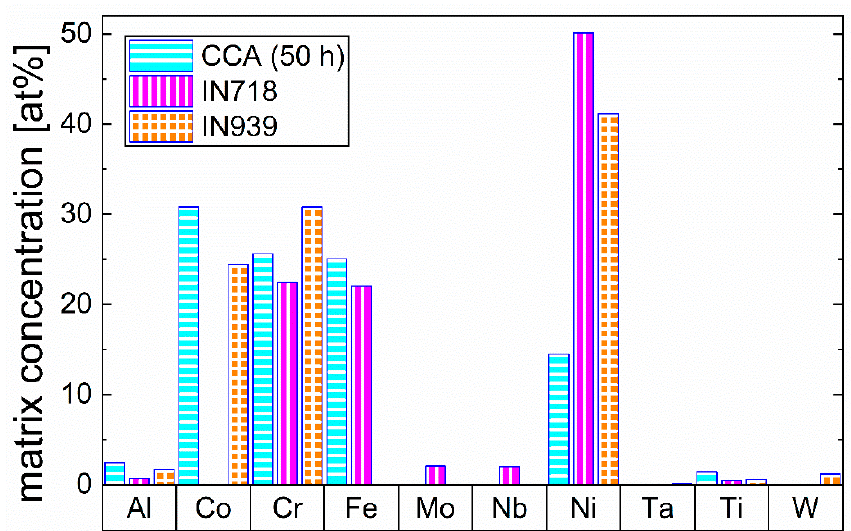
Figure 8. Comparison of the chemical composition of the matrix phase of the CCA after 50 h of aging with the matrix composition of Ni-based IN718 [20] and IN939 [21] alloys from the literature. Significant differences between the matrix compositions can be